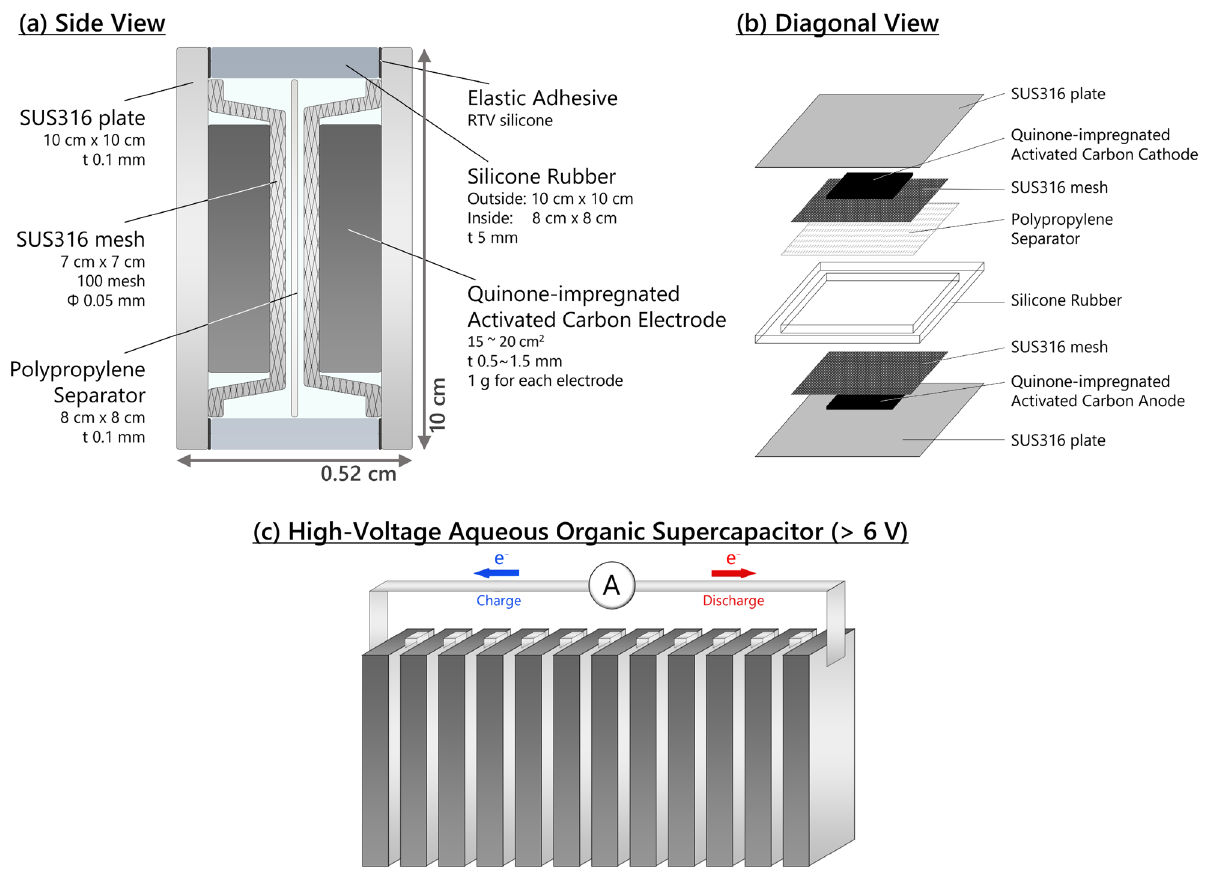
Figure 1. Illustrations of the cell configuration of a 10 cm × 10 cm × 0.52 cm single cell from ( a ) side view and ( b ) diagonal view. ( c ) A high-voltage aqueous organic supercapacitor (> 6 V) by connecting twelve single cells in